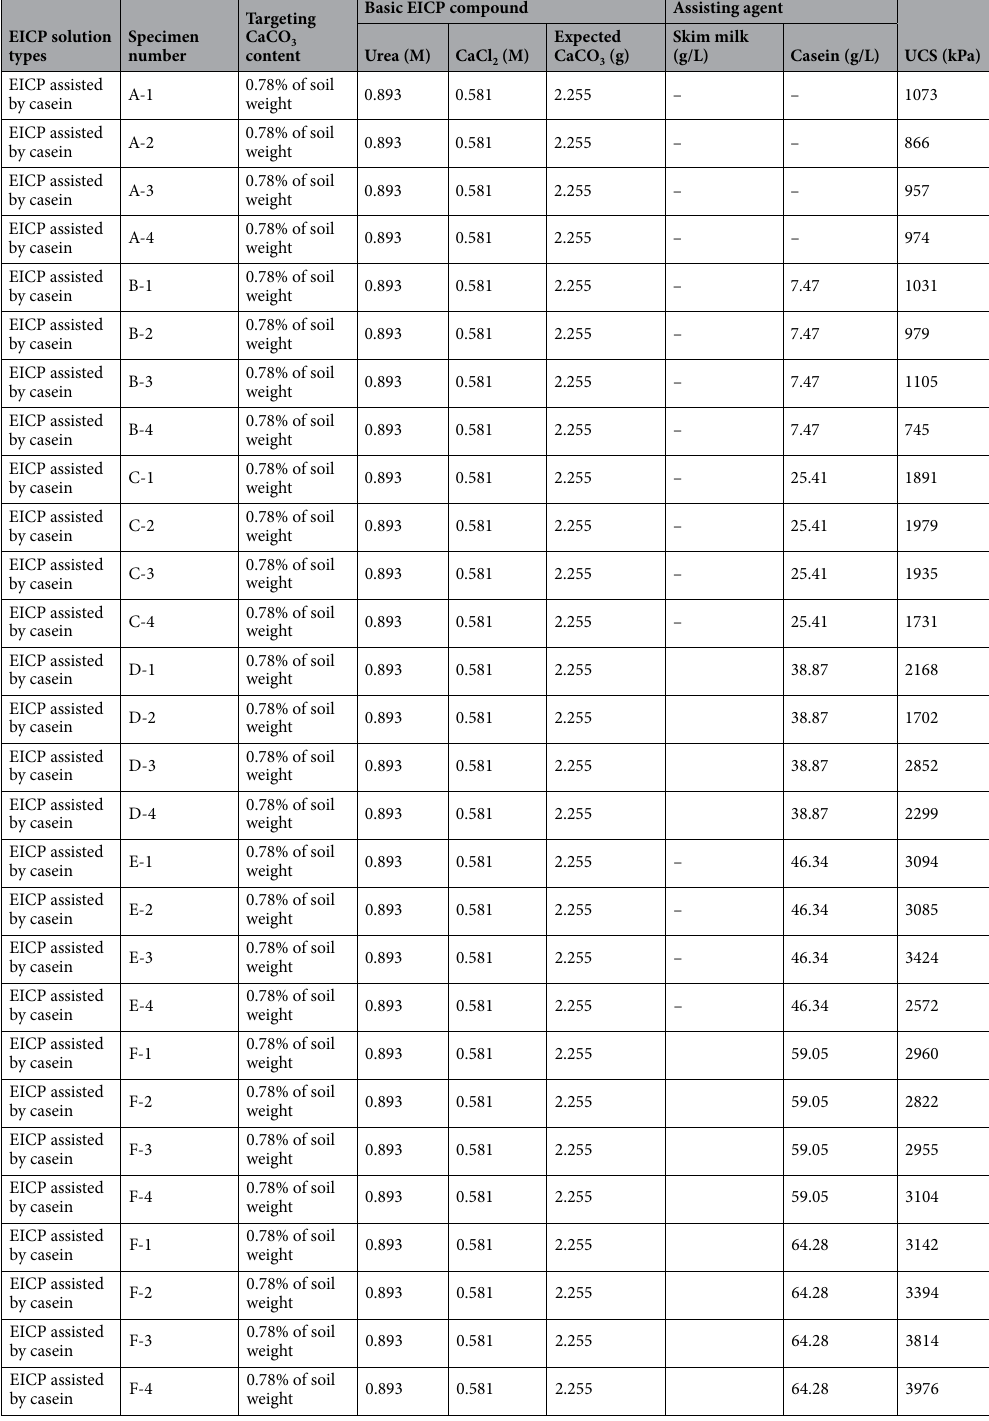
Table 1. Specimen information and corresponding UCS results of the casein-content optimization study with fixed EICP concentration. All specimens involved 2.6 g/L of urease enzyme. The casein concentrations